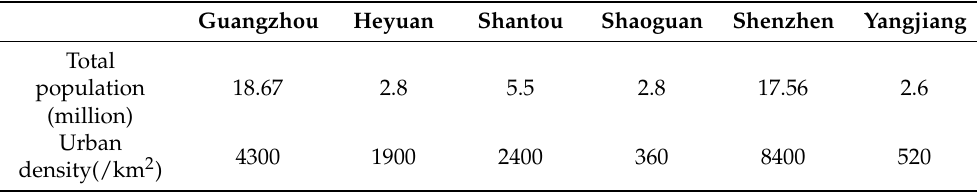
Table 1. Comparison of Guangzhou with other five cities in terms of population and density.